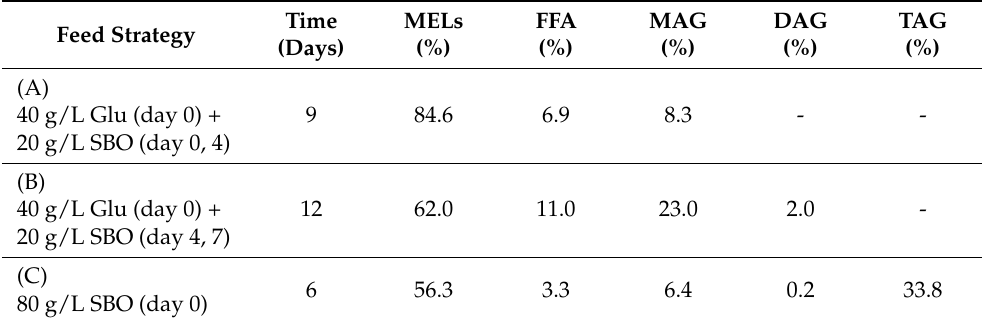
Table 1. Composition of crude MELs obtained in the end of fermentation, based on the feed strategy employed.; Glu—glucose; SBO—soybean oil; FFA—free fatty acids; MAG—monoacylglycerides; DAG—diacylglycerides; TAG—triacylglycerols. Feed